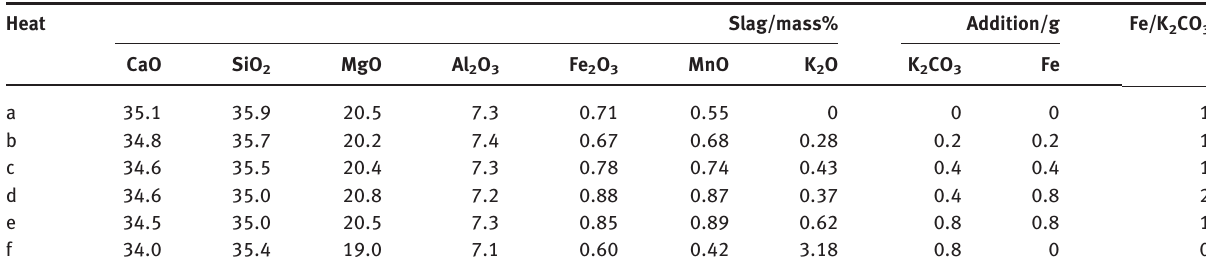
Table 3: Chemical compositions of slag after reaction.